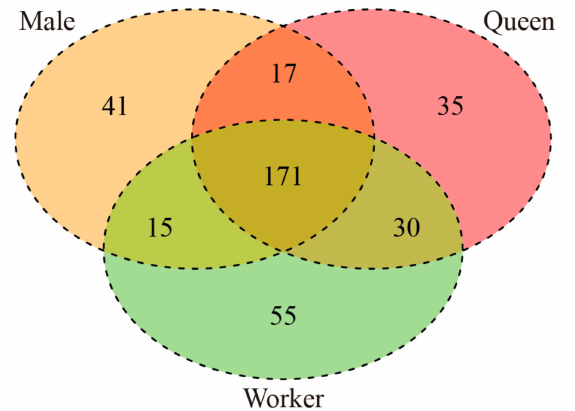
Figure 2. Distribution of known microRNAs (miRNAs) in the three B. lantschouensis castes. The